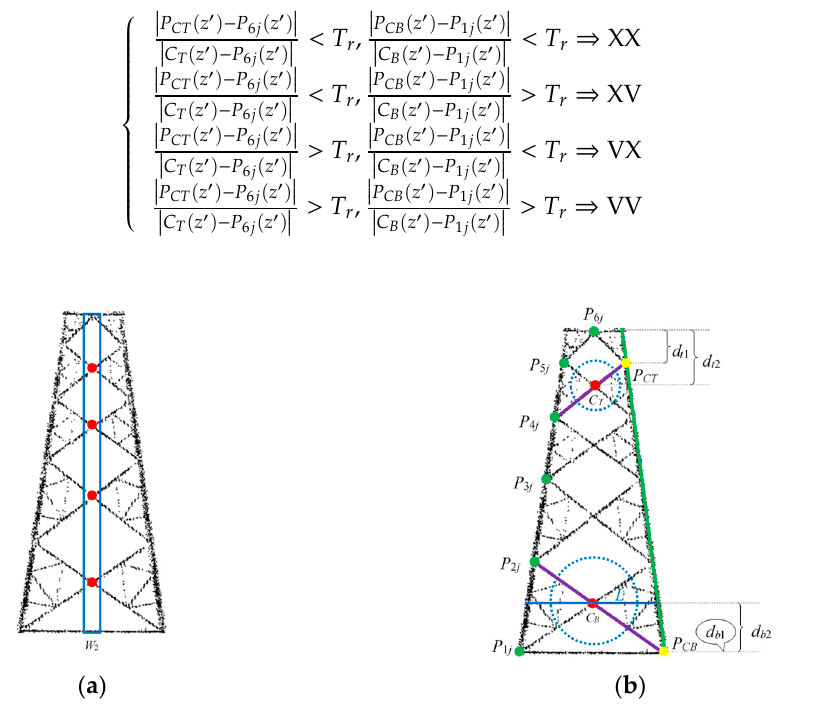
Figure 17. The diagram of the internal structure reconstruction: ( a ) The intermediate intersection; ( b ) the internal structure identification.